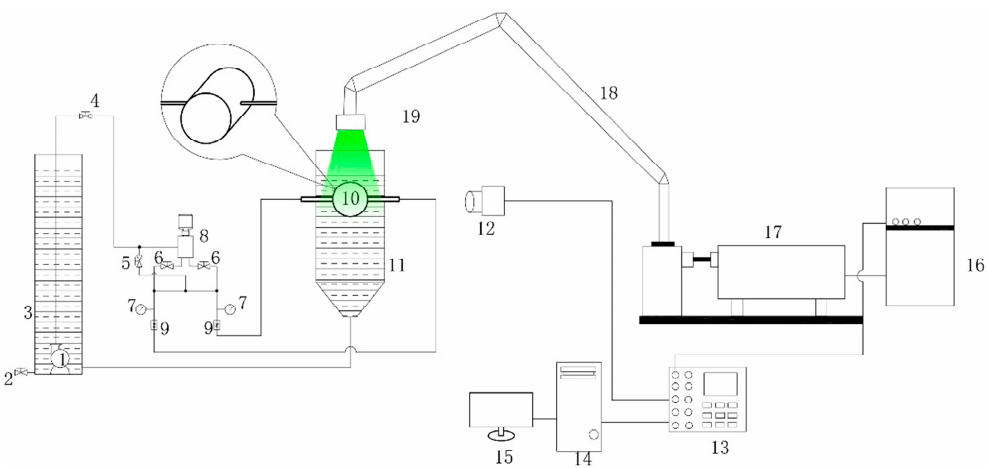
Figure 4. Schematic of the experimental system. 1—pump; 2,4,5,6,9—valve; 3—buffer tank; 7—flow meter; 8—shunting device; 10—cylindrical collision chamber; 11—conical tank; 12—CCD camera; 13—synchronous controller; 14—image acquisition workstation; 15—monitor and software interface; 16—laser controller; 17—pulse laser; 18—light arm; 19—optical parts.